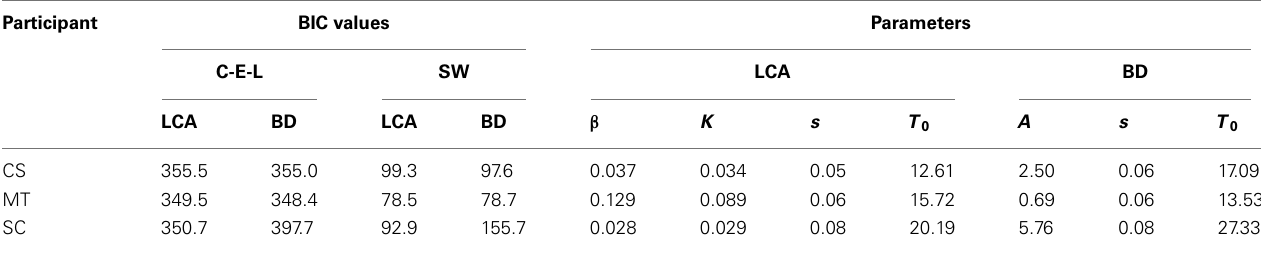
Table 1 | Bayesian information criterion values and model parameters for the LCA and BD models for the three subjects in experiment 1B. Participant BIC values